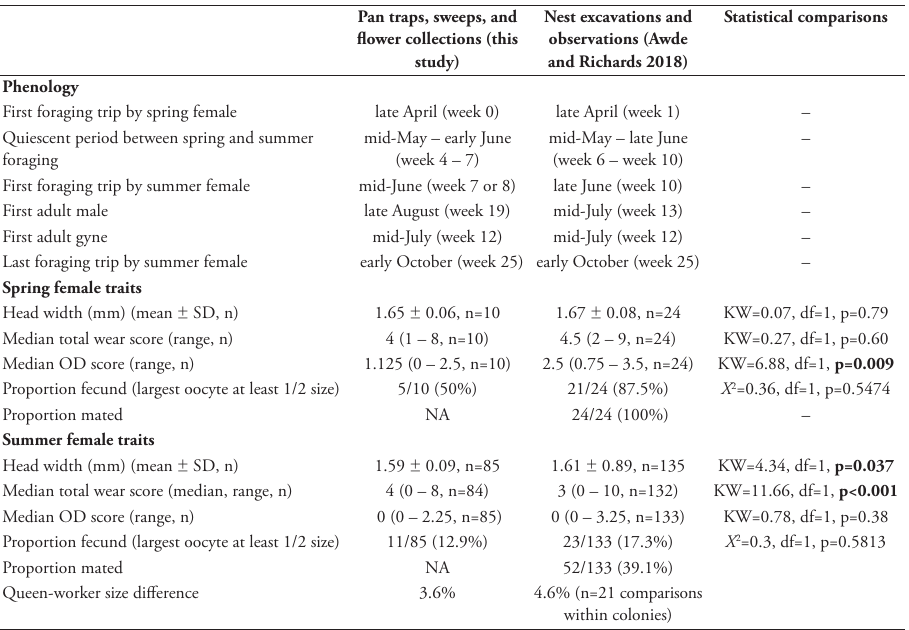
Table 2. Phenological events and social traits of L. laevissimum females inferred from passive collections and nest excavations. Spring females from Awde and Richards (2018) were queens collected from nests in summer that would have been foraging in spring, while summer females were workers collected from nests in summer. Statistical comparisons are for pinned females assessed in this study versus females collected from nests in Awde and Richards